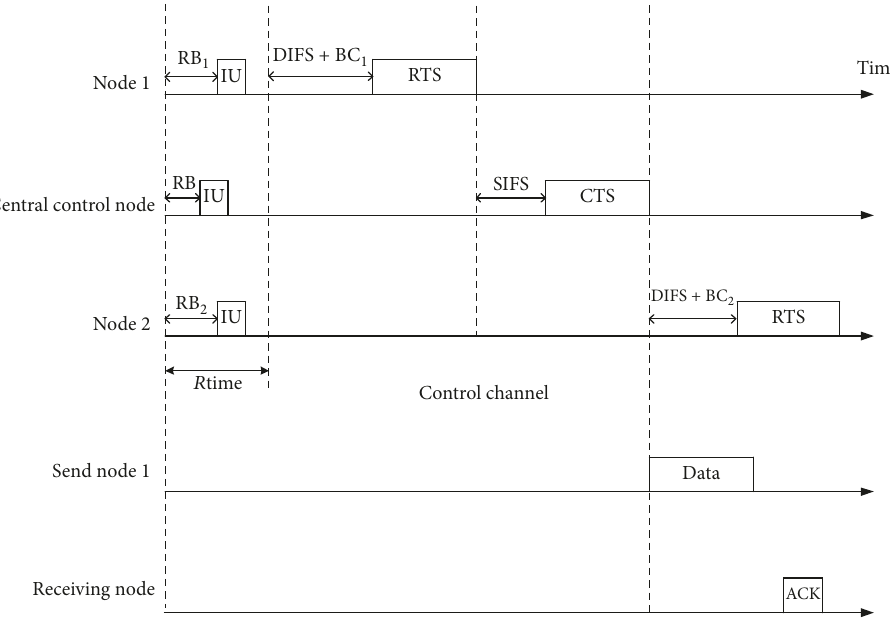
Figure 1: Medium access control